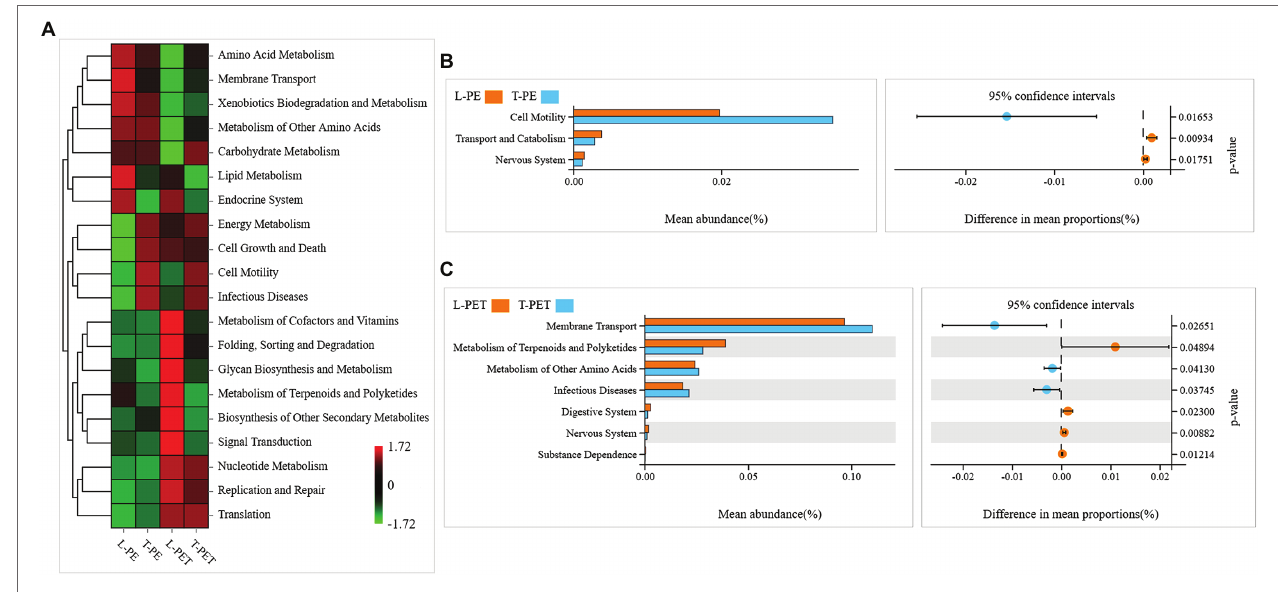
FIGURE 6 | Potential metabolic functions of biofilm bacterial communities on PE and PET materials according to Kyoto Encyclopedia of Genes and Genomes (KEGG) metabolic pathway (level 2). The correlations between each sample group and top 20 metabolic functions in KEGG pathway are shown in heatmap (A) . The column and dot plots (B,C) show the mean abundance and difference in mean proportions of metabolic functions, which are significantly dissimilar ( p < 0.05) between two biofilm sample groups using Welch’s t